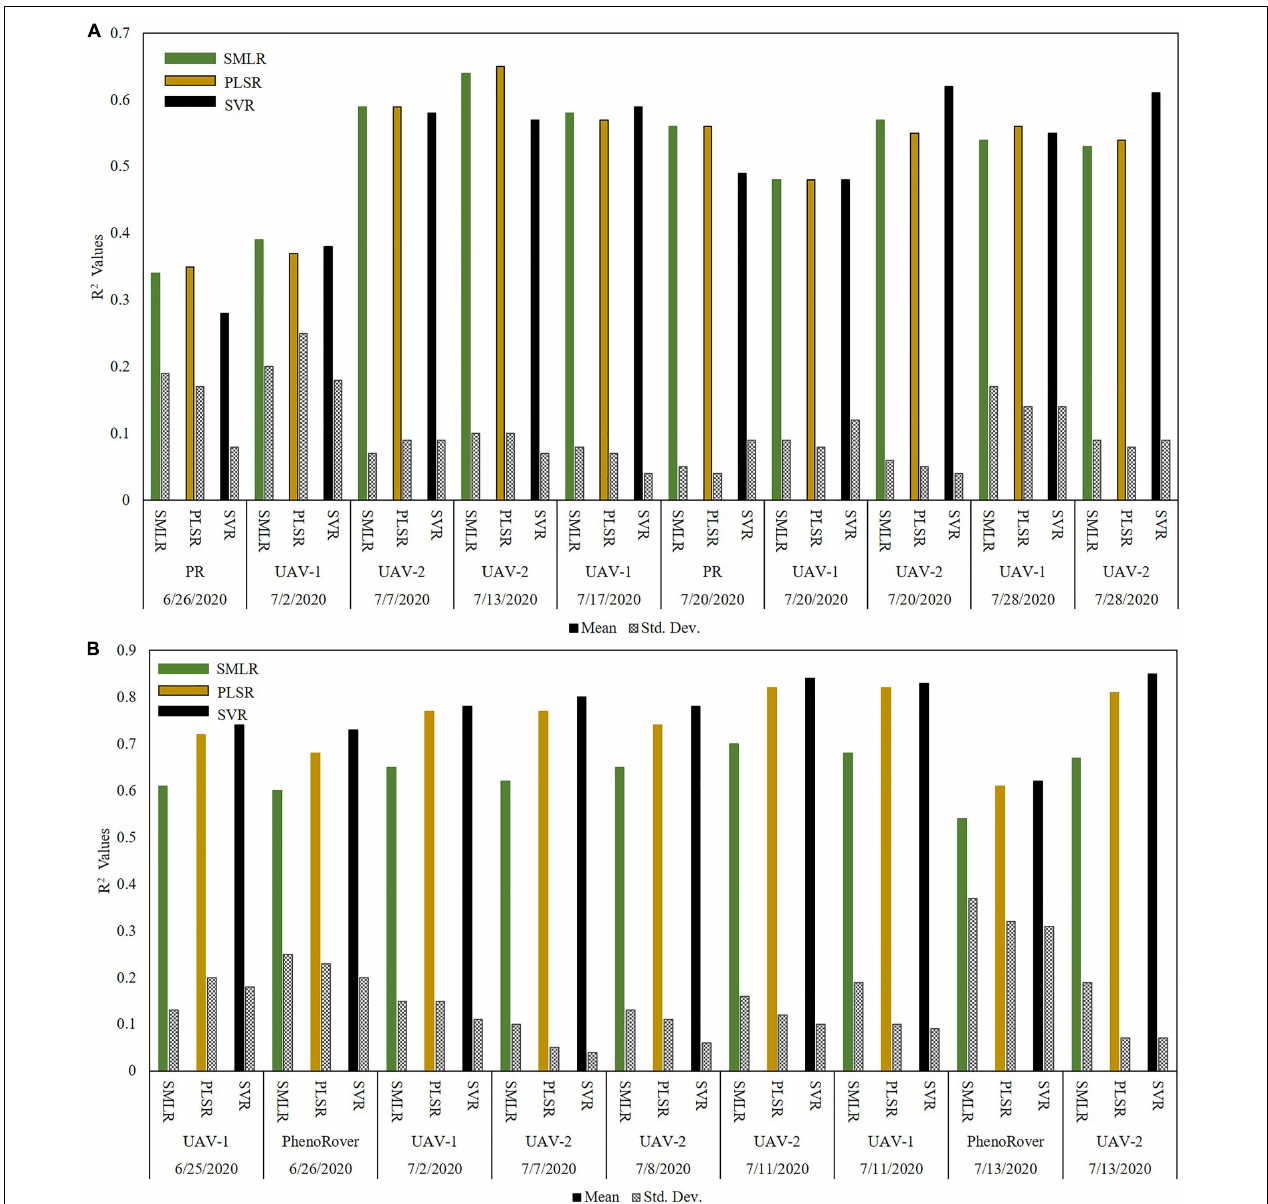
FIGURE 11 | R 2 values for 2020 regression models for LAI estimation (A) SbDivTc_Cal and (B) HIPS; (PR: